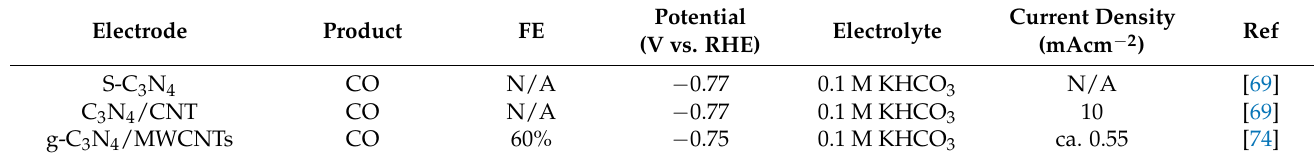
RHE. Table 7 shows the electrocatalytic parameters of non-metal doping g-C 3 N 4 catalyst for CO 2 RR. Table 7. Electrocatalytic parameters of non-metal doping g-C 3 N 4 catalysts on eCO 2 RR. Electrode